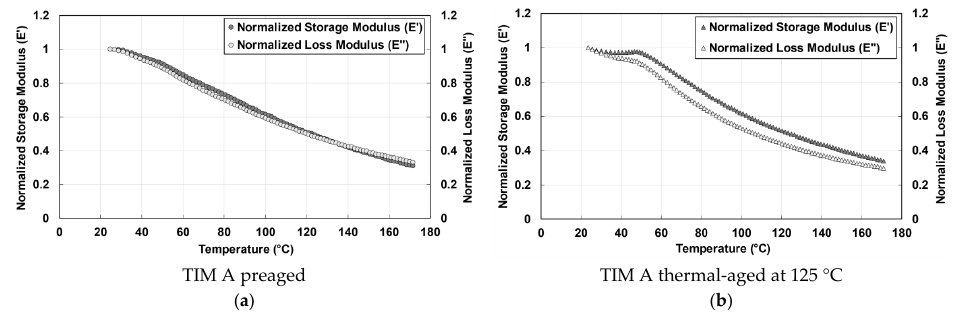
Figure 7. Storage modulus ( E ′) and loss modulus ( E ″), ( a ) TIM A preaged, and ( b ) ( E ″) TIM A thermal-aged at 125 °C.